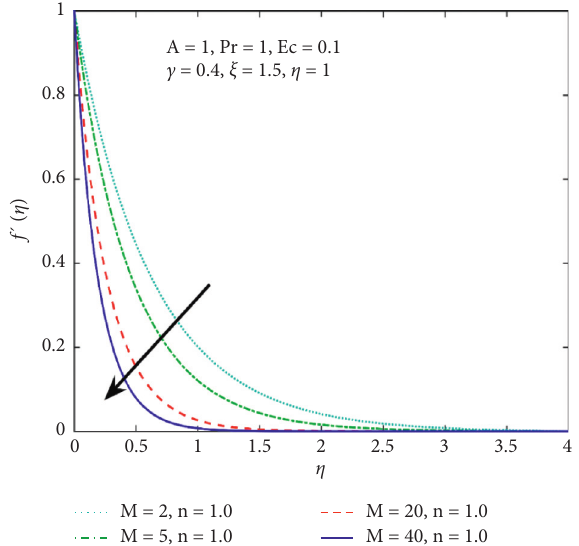
Figure 2: Velocity profile f ′ ( η ) for different values of magnetic parameter ( M ) .